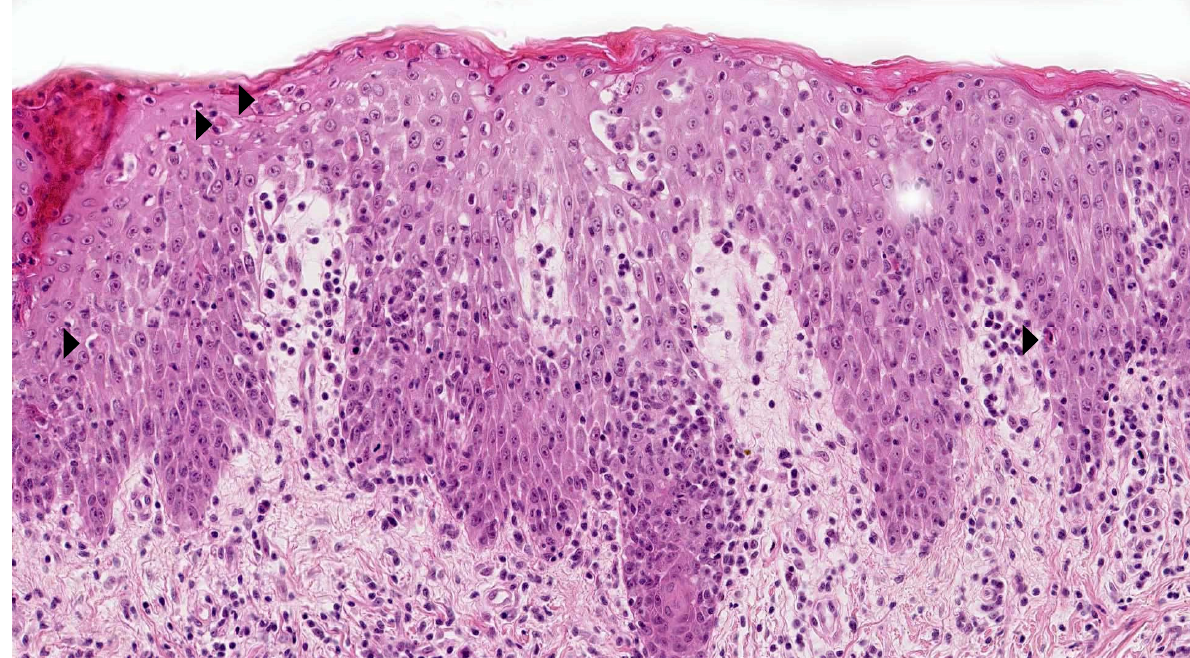
Figure 2. IPEX syndrome: Epidermal hyperplasia, marked lymphocytic exocytosis, scattered apoptotic keratinocytes (arrowhead), and a moderate lymphocytic infiltrate in the superficial dermis. HE ×400.